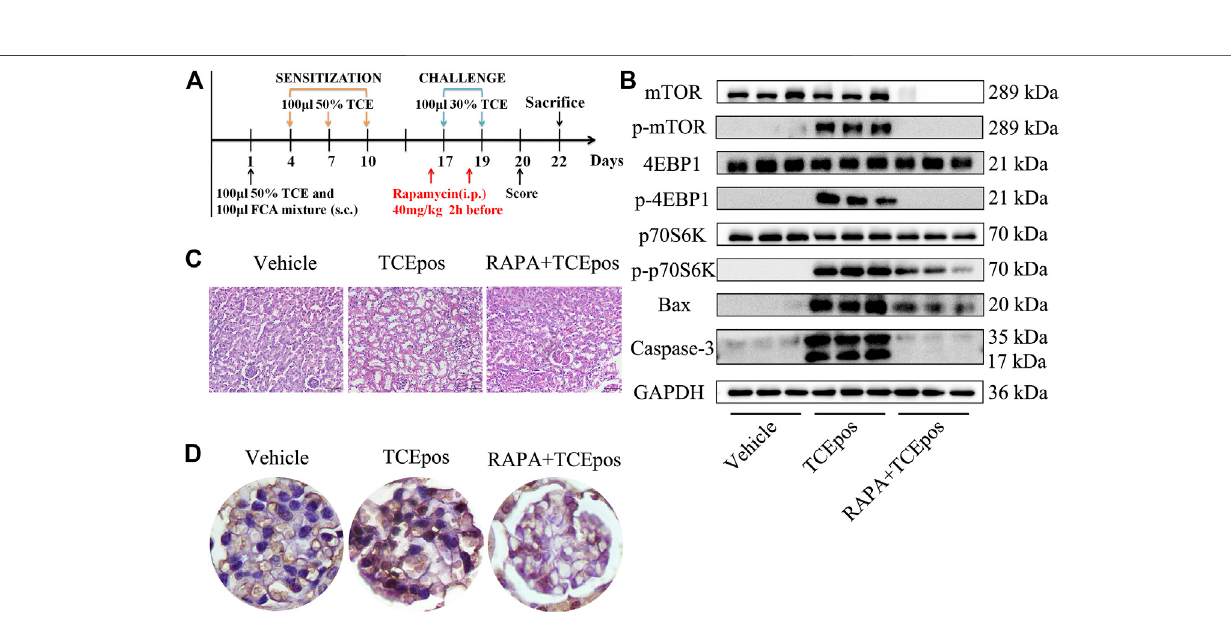
FIGURE6| Hyperactive mTORC1 pathwaywasinvolvedinTCE-inducedglomerulardamage. (A) Western blotbandsofmTORC1signalingmolecules,mTORC1, p-mTORC1, 4EBP1, p-4EBP1, p70S6K, and p-p70S6K, in blank control group, vehicle control group, TCEpos group, and TCEneg group ( n (cid:1) 3 per group) (B – D) The relative expression of p-mTOR (B) , p-4EBP1 (C) , and p-p70S6K (D) calculated by gray values in ImageJ software in above groups. Data are presented as mean ± SD and determined by one-way ANOVA, a P < 0.05, vs. blank control group; b P < 0.05, vs. vehicle control group; c P < 0.05, vs. TCEneg group.